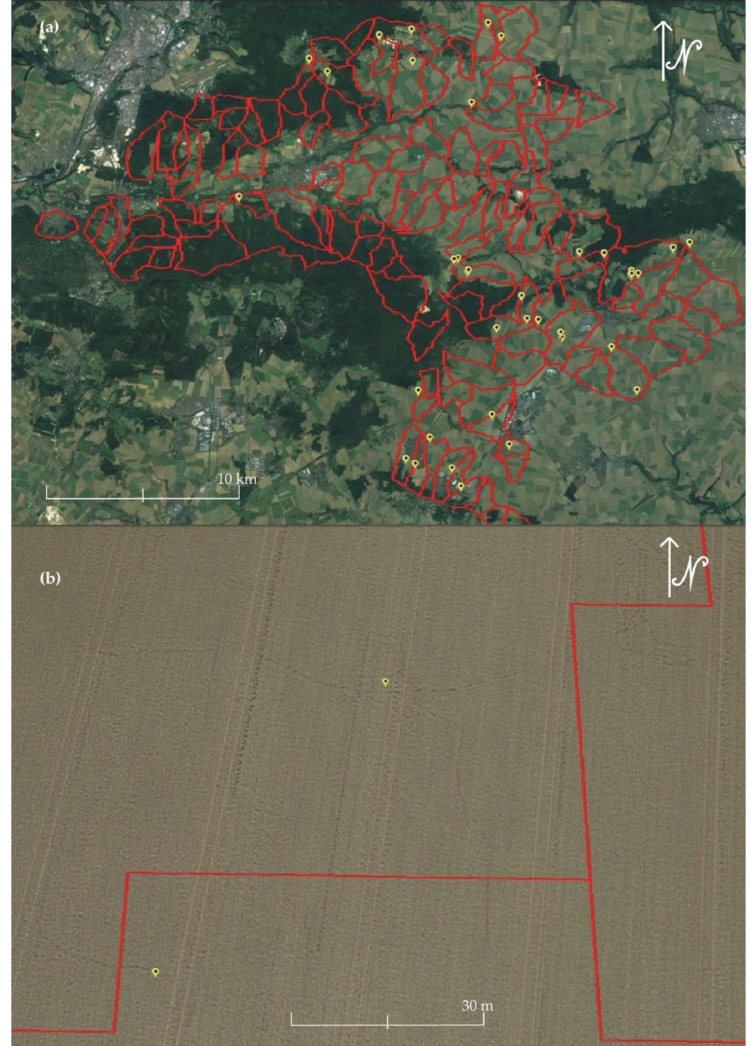
Figure 6. ( a ) Surficial silent witnesses on the scale of Nonette catchment; ( b ) zoom on the type of surficial silent witnesses distinguished from aerial pictures (Google Earth)